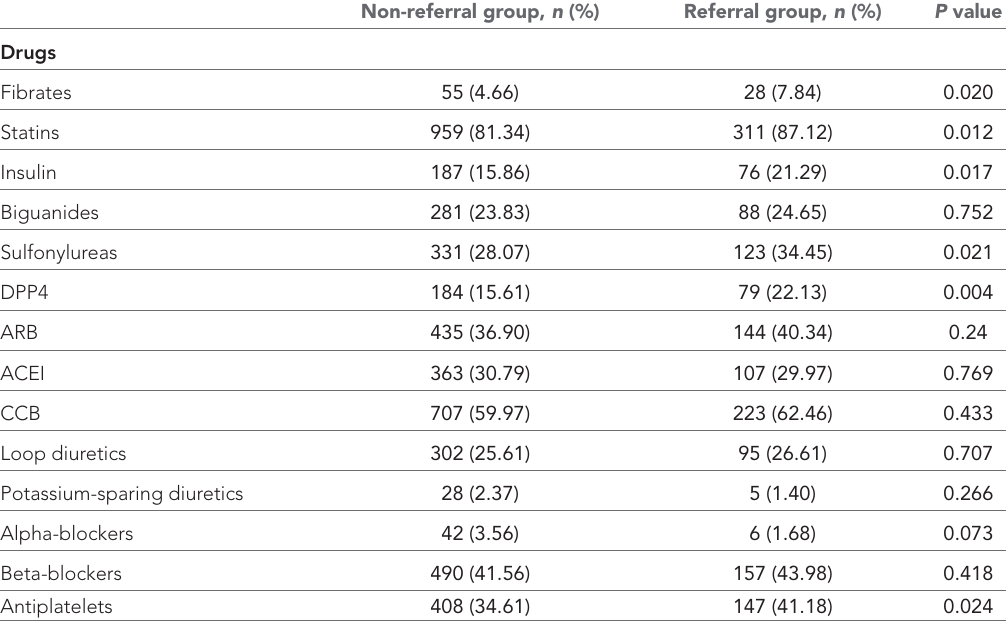
Table 4 Comparisons of patient medications between non- referral and referral groups Non- referral group, n (%) Referral group, n